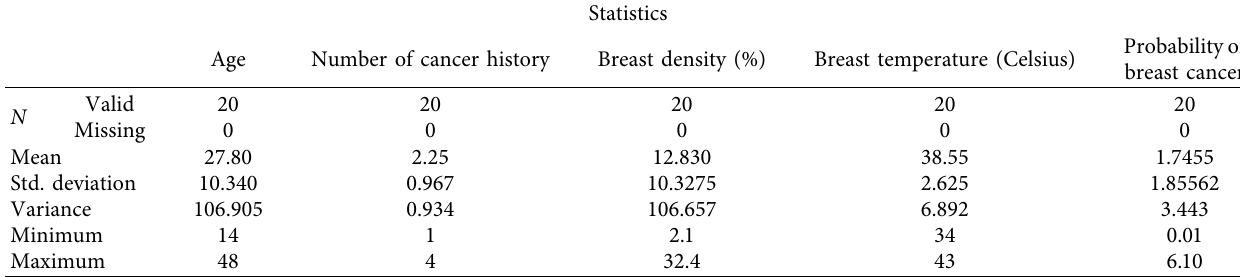
Table 4: Descriptive statistics showing minimum, maximum, mean, variance, and standard deviation values.